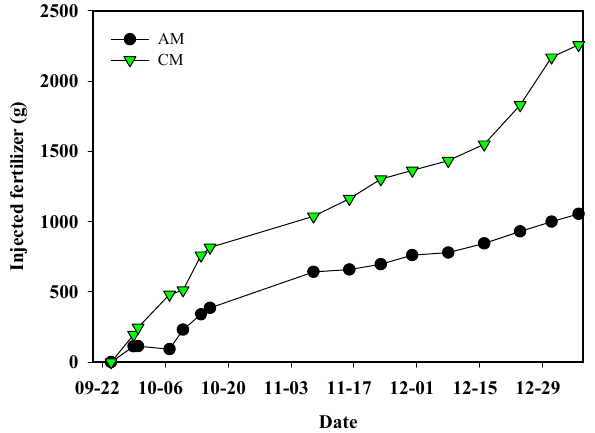
Figure 6 Accumulated amounts of fertilizers injected into the soilless culture systems with conventional (CM) and alternative (AM) nutrient-replenishment methods.